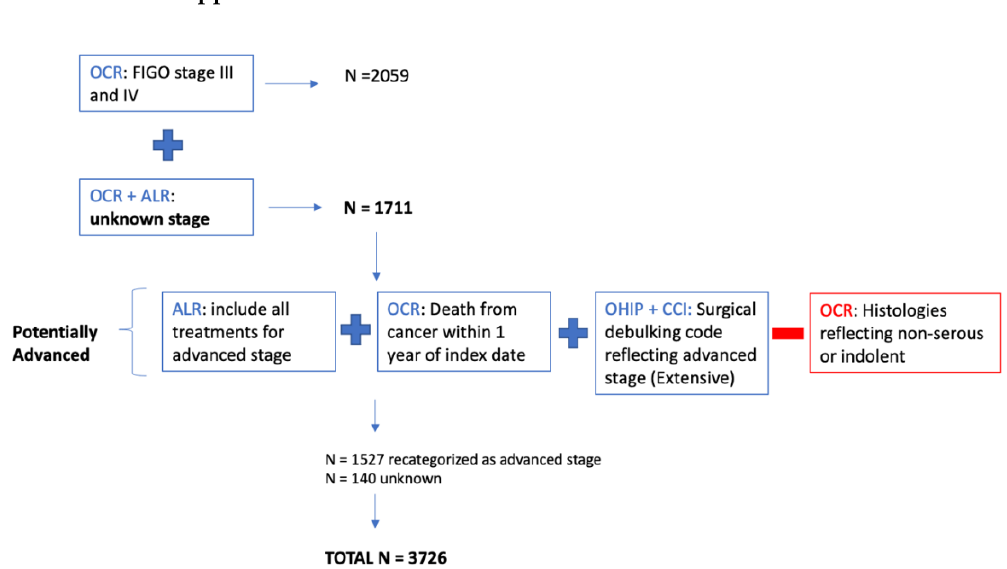
Figure A1. Algorithm to determine potentially advanced stage for unknown stage category.